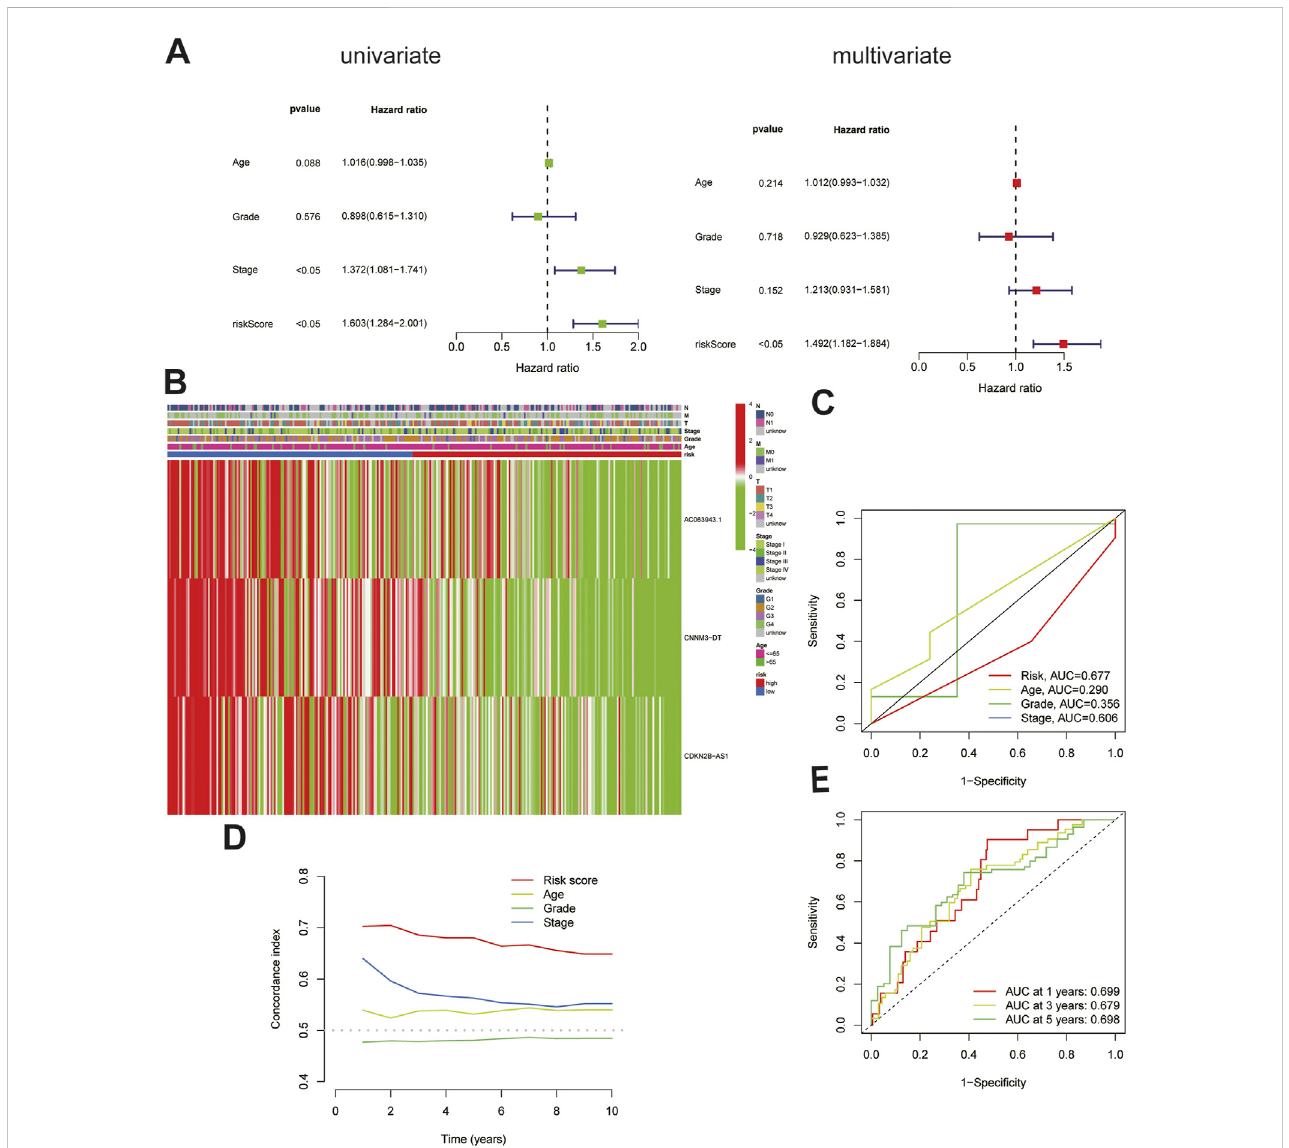
FIGURE 3 Validation of the cuproptosis-related lncRNA signature. (A) The cuproptosis-related lncRNA signature was shown to be an independent risk factor for patients ’ overall survival in TCGA. (B) The heatmap shows the expression of signature in the high and low risk group and their relationship with other clinicopathological signatures. (C) The AUC showed that riskscore was an independent predictor compared with other clinicopathological signatures. (D) The C-Index of the riskscore was higher than other clinicopathological signatures. (E) The signature could be used as an independent predictor to predict the OS of 1-,3-,5